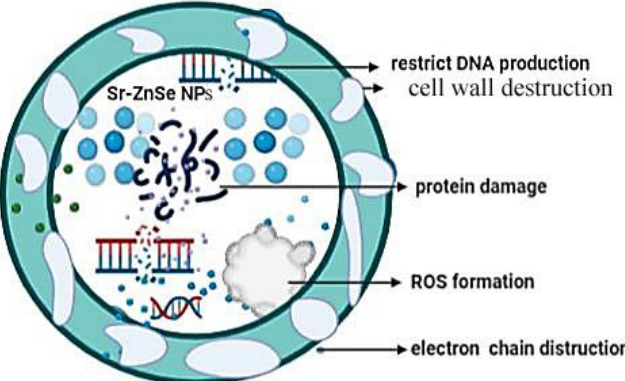
Figure 9. Antibacterial activity mechanism of Sr-doped ZnSe nanoparticles.